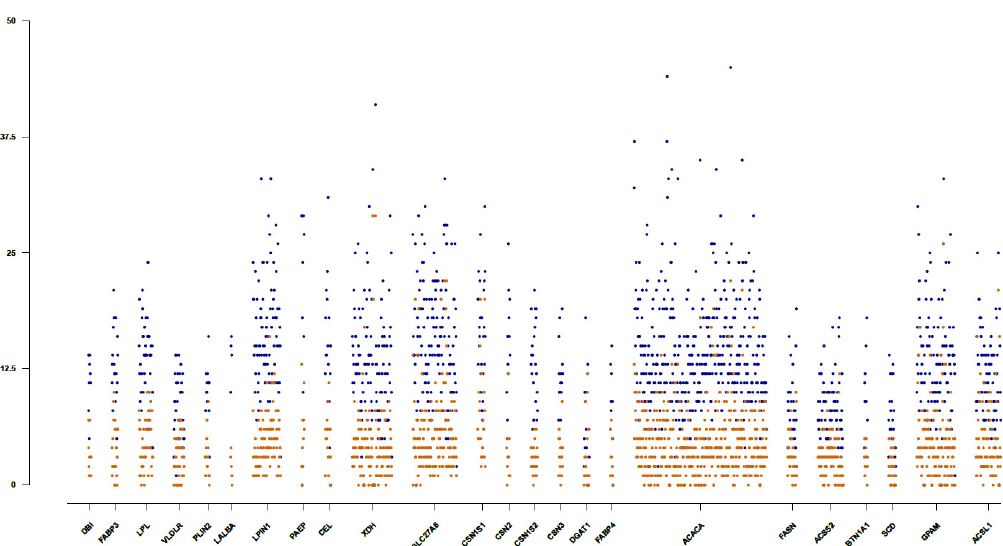
Figure 2. Density of total and novel variants identified in candidate gene regions. Manhattan plot showing the number of variants identified per 500 bp across the selected candidate gene regions. The total and novel variants uncovered in this study are represented in blue and orange colors, respectively.